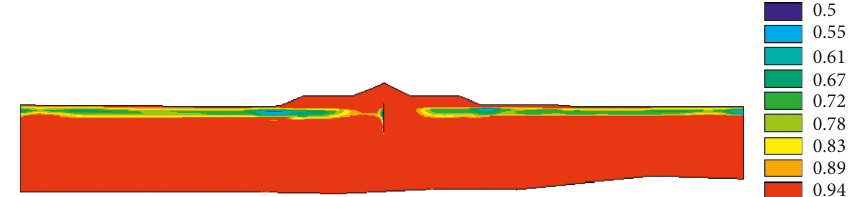
Figure 10: The distribution of ratio of cyclic shear strength to static shear strength.